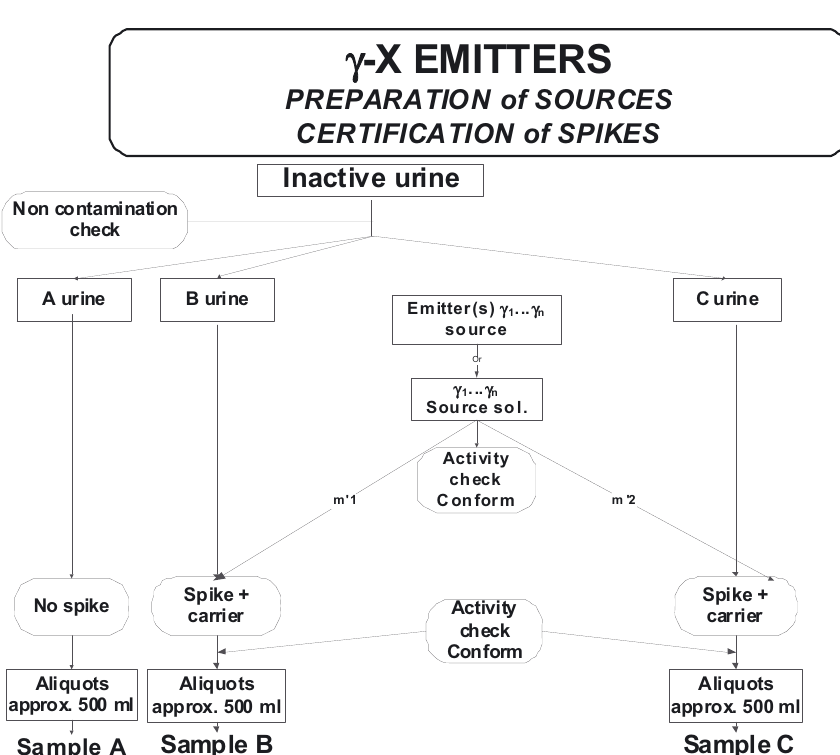
Fig. 1. Preparation of the gamma-X comparison